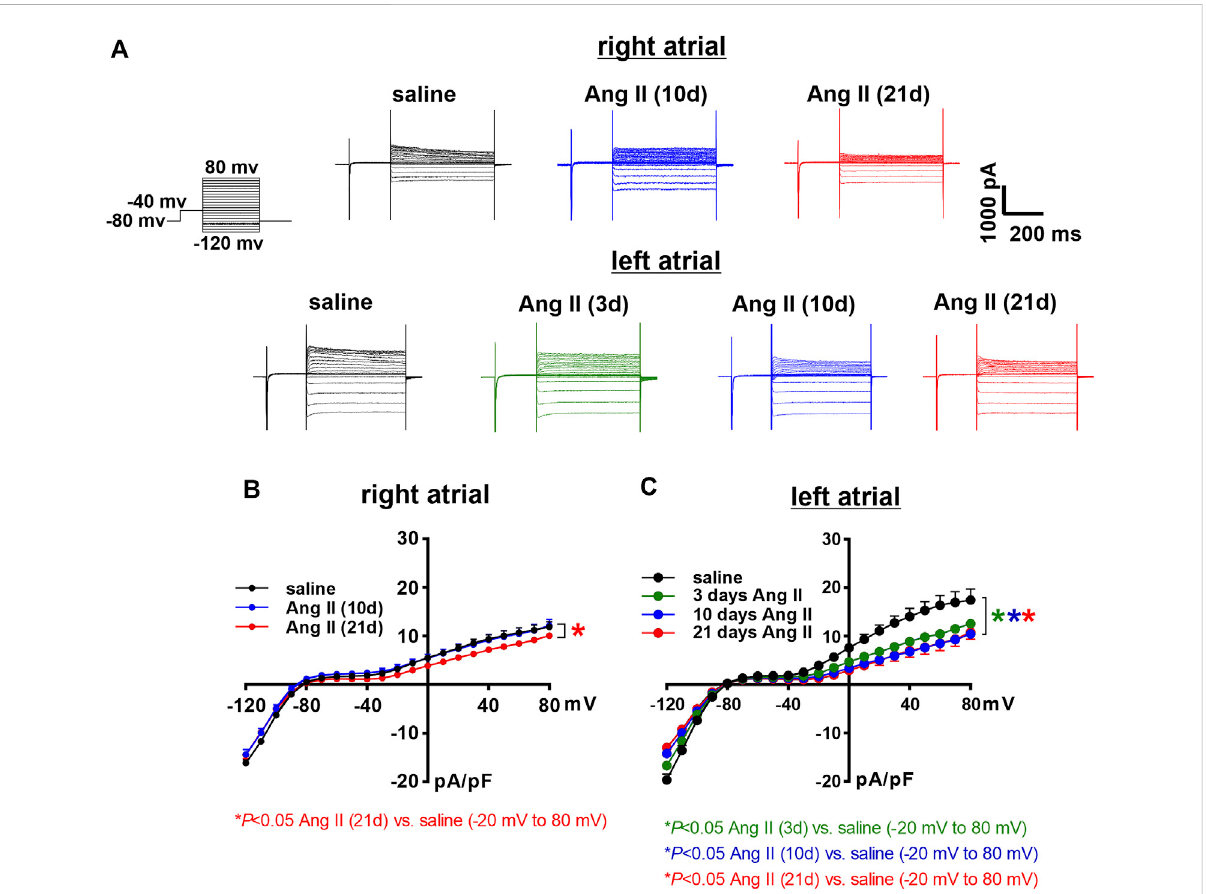
FIGURE 8 Time course of the effects of Ang II on right and left atrial potassium currents after an inactivating pre-pulse. (A) Representative I K recordings following apre-pulse toinactivate I to inrightand left atrialmyocytes isolated from mice infused with saline for 21 days orAng II for 3,10 and 21 days. Voltageclampprotocolshownbesiderecordings. (B) SummaryI K IVcurves,measuredatthepeakoftheI K recordingsfollowingapre-pulse,forright atrial myocytes isolated from mice infused with saline or Ang II for 10 and 21 days. (C) Summary I K IV curves, measured at the peak of the I K recordings following a pre-pulse for left atrial myocytes isolated from mice infused with saline or Ang II for 3, 10 and 21 days. * p < 0.05 vs saline at indicated membrane potentials by two-way repeated measures ANOVA with a Holm-Sidak posthoc test. For right atrial myocytes n =12 for saline, 14 forAng II(10 days)and 21 for AngII (21 daysay). Forleftatrialmyocytes n =11 forsaline,15 for AngII (3 days), 17for AngII (10 days) and 12for AngII (21